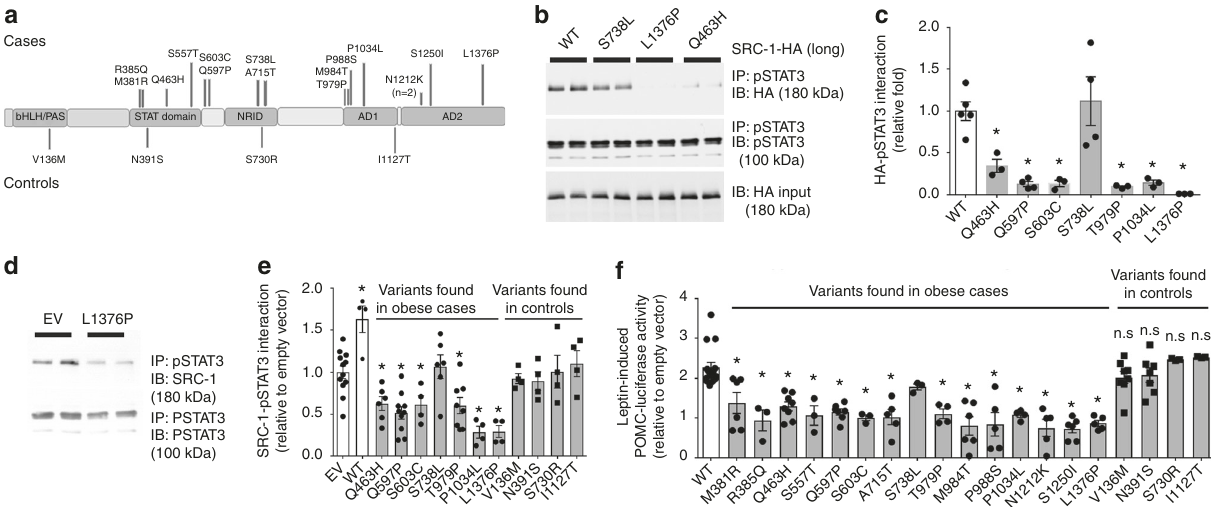
Fig. 3 Missense variants in SRC-1 disrupt leptin signaling. Numbers of experiments are indicated; data are presented as mean ± SEM and compared using one-way ANOVA followed by post hoc Sidak tests unless mentioned otherwise. a Rare variants identi fi ed in individuals with severe early onset obesity (above) and in controls (below). b , c HEK293 cells were co-transfected with leptin receptor vector and human STAT3 vector. Cells were treated with leptin (200 ng/ml, 15 min) to induce phosphorylation of STAT3. pSTAT3 was pulled down using anti-pSTAT3 sepharose beads; beads were then aliquoted equally and incubated with the same amount of the long isoform of human SRC-1-HA (WT/mutant) and interactions between the pSTAT3 and SRC-1 were determined by CoIP experiments using anti-pSTAT3 and anti-HA antibodies. b Representative blots showing interactions between pSTAT3 and SRC-1 (WT/mutant), and inputs of pSTAT3 and SRC-1-HA. c Quanti fi cation for WT and SRC-1 mutants. Comparative folds were calculated as the ratios of HA blots and HA inputs ( n = 3 – 5); * P < 0.05. d , e SRC-1 mutants inhibit the interaction between STAT3 and WT SRC-1. HEK293 cells were co-transfected with leptin receptor vector, STAT3 vector, and mutant SRC-1 vector (or empty vector). Cells were treated with leptin (200 ng/ml, 15 min) to induce phosphorylation of STAT3 and interactions between pSTAT3 and total SRC-1 were determined by CoIP experiments using anti-pSTAT3 and anti-SRC-1 antibodies. d Representative blots showing interactions between pSTAT3 and SRC-1 variants found in obese cases and inputs of pSTAT3. e Quanti fi cation. Comparative folds were calculated as the ratios of SRC-1-pSTAT3 interaction blots and pSTAT3 inputs ( n = 4 – 12); * P < 0.05. f SRC-1 variants impair POMC expression. Neuro2A cells were co-transfected with leptin receptor vector, SRC-1 (WT or mutant) and a POMC luciferase expression reporter construct. Cells were stimulated with 200 ng/ml leptin for 15 min and then incubated for 6 h, following which luminescence was measured. Results were